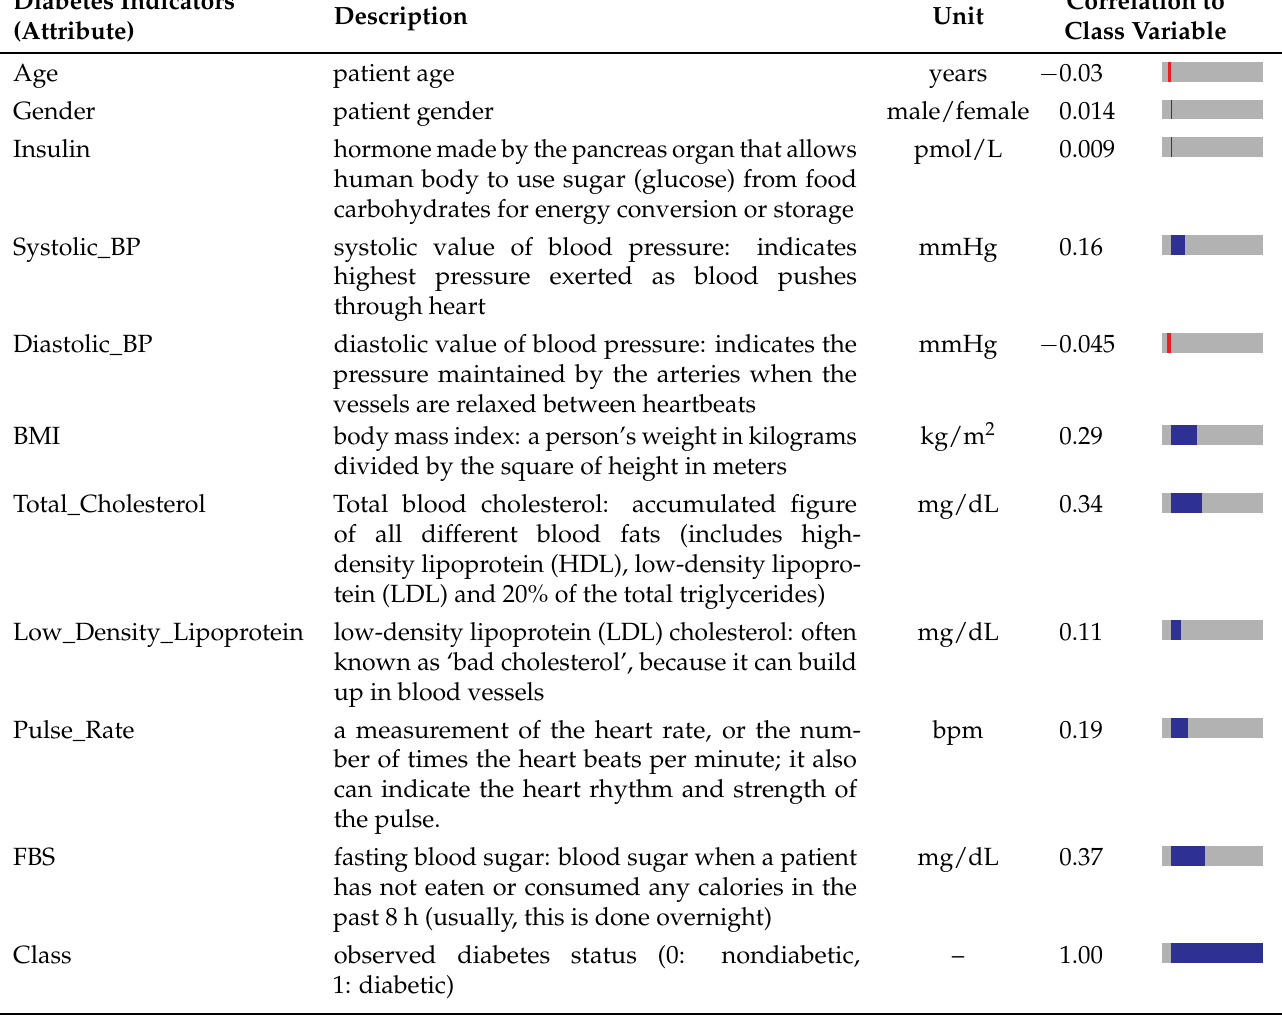
Table 1. Description of ZMHDD